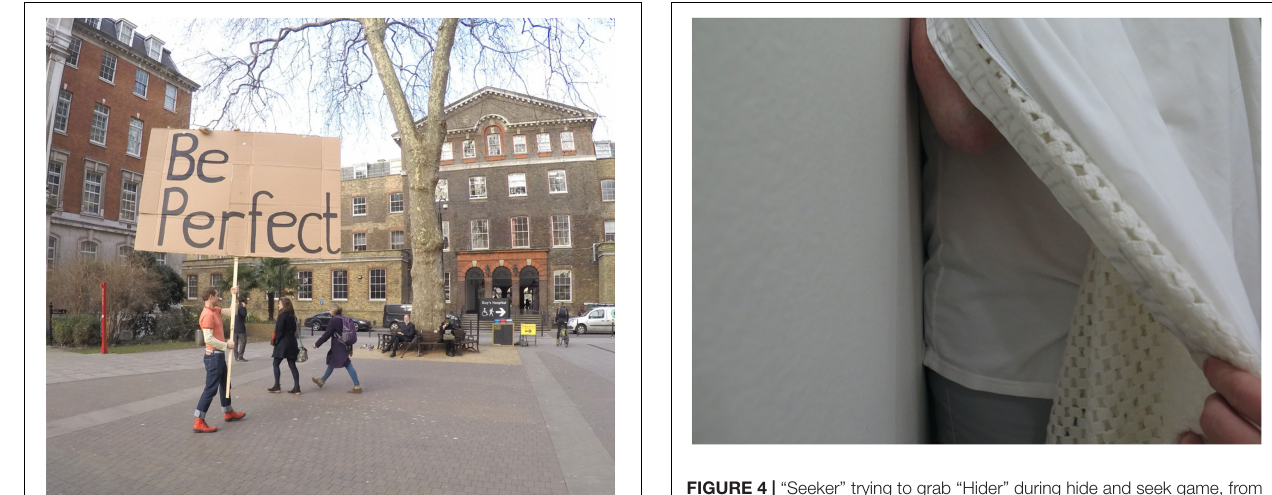
education that have been articulated by those within the field.